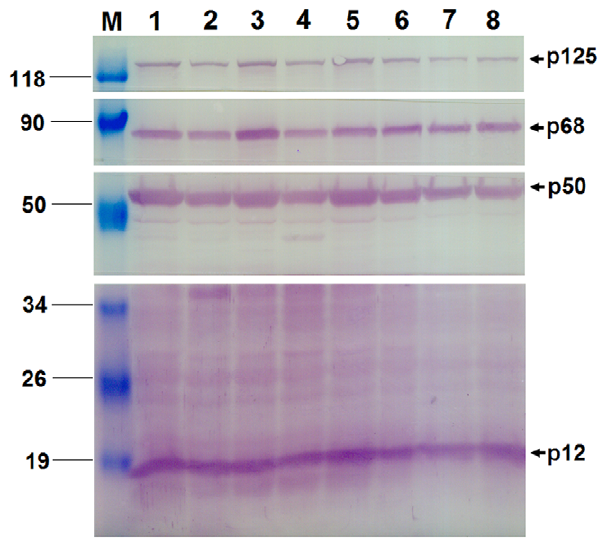
Figure 3. Western blotting analysis for the generation of the recombinant BmNPV viruses in BmN cells. Eight bacmid DNAs, isolated from the white clones and verified by PCR analysis, were transfected into BmN cells. After 5 days post-transfection, each supernatant was harvested as the viral stocks and the cell pellets were analyzed by Western blotting using the antibodies specific for the individual subunit as described under ‘‘Materials and Methods’’. M indicates the positions in kDa of protein markers. The lanes from 1 to 8 show eight independent transfections of BmN cells with recombinant BmNPV bacmid DNAs. Pol d four subunits are marked by